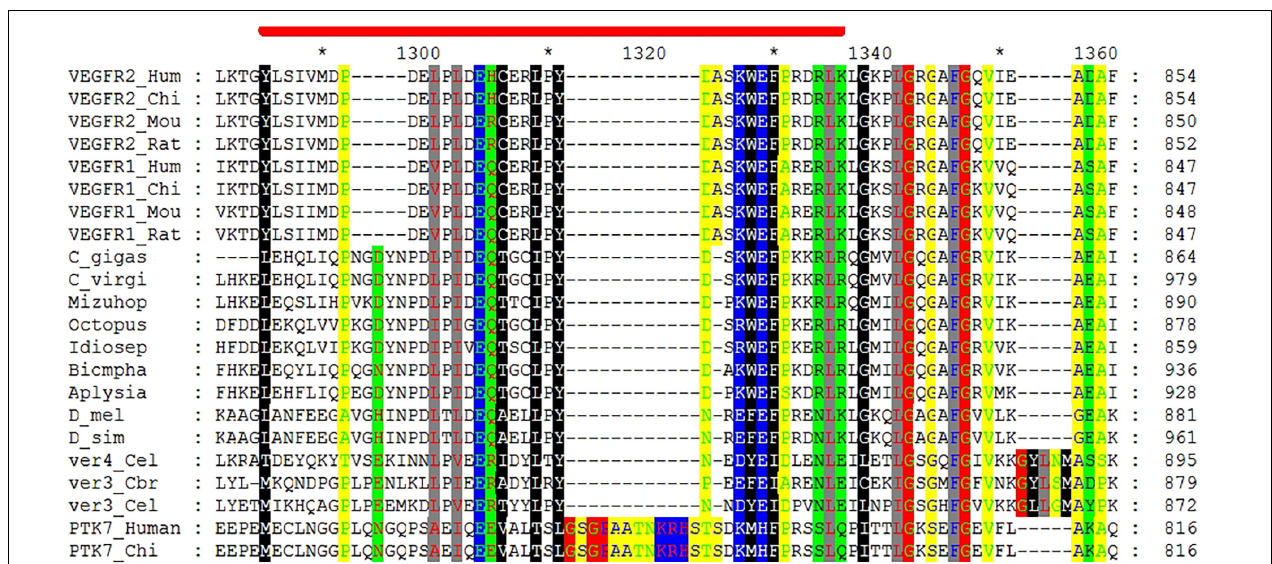
FIGURE 2 | Section of the multiple sequence alignment of VEGFR proteins sequences that shows conservation of physicochemical properties of residues involved in interactions with axitinib. The coordinates on right refer to the absolute amino acid position number for each sequence, while coordinates above the alignment refer to the position in the alignment. Red stripe marks the span between Y801 and K826 residues of human VEGFR2 involved in axitinib binding according to McTigue et al. (2012). The species name abbreviations, top to bottom, are Hum (human), Chi (chimpanzee), Mou (mouse), Rat (rat), C. gigas , C. virgi ( C. virginica ), Mizuhop ( Mizuhopecten yessoensis ), Octopus ( Octopus bimaculoides ), Idiosep ( Idiosepius paradoxus ), Biompha ( Biomphalaria glabrata ), Aplysia ( Aplysia californica ), D_mel ( Drosophila melanogaster ), D_sim ( Drosophila simulans ), Cel ( Caenorhabditis elegans ), and Cbr ( Caenorhabditis briggsae ). The following sequences (GenBank, FlyBase, or Ensembl accession numbers) were used in the alignment (top to bottom): ENSG00000128052, ENSPTRP00000027639, ENSMUSP00000109144, ENSRNOP00000066886, P17948.2, ENSPTRP00000009777, ENSMUSP00000031653, ENSRNOP00000001248, EKC41995.1, XP_022322561.1, OWF52925.1, XP_014782180.1, BAI67804.1, XP_013075054.1, XP_012937883.1, NP_787997.2, FBpp0313964, NP_509835.2, CAP35166.2, NP_509836.1, Q13308.2, and ENSPTRG00000018188. Conserved sites containing amino acid residues with identical physicochemical properties show polar (black lettering, green background), hydrophobic (white lettering, black background), positively charged (pink lettering, blue background), amphoteric (red lettering, green background), small (green lettering, yellow background), aliphatic (red lettering, gray background), negatively charged (green lettering, blue background), and charged (white lettering, blue background)